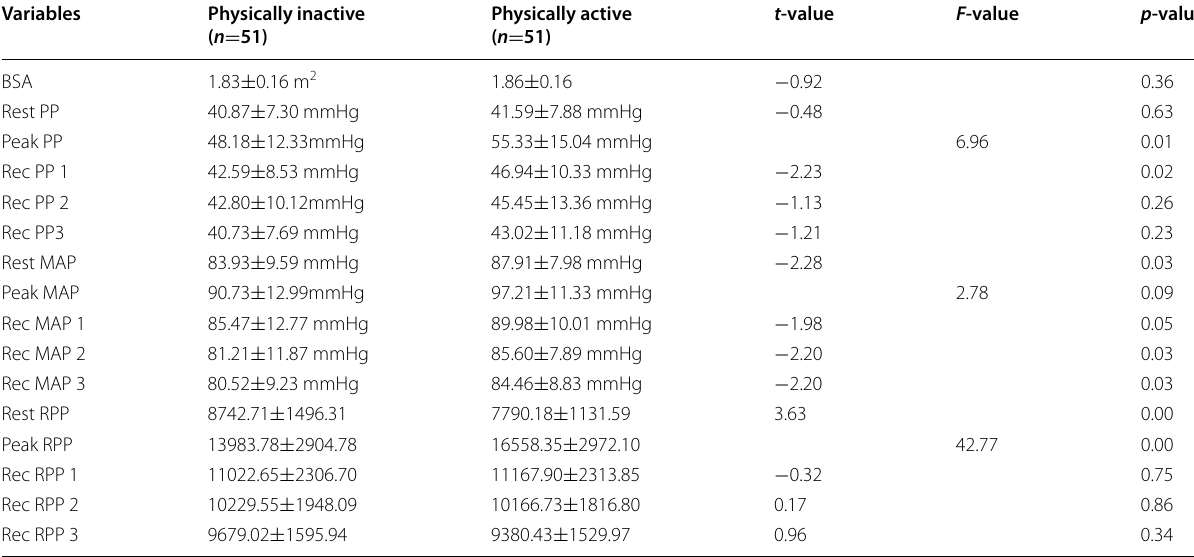
Rest PP Resting pulse pressure, peak PP Peak pulse pressure, rest MAP Resting mean arterial pressure, peak MAP Peak mean arterial pressure, rec PP1, 2, and 3 , pulse pressure 1, 3, and 5 min after exercise; rec MAP 1, 2, 3 , mean arterial pressure 1, 3, and 5 min after exercise; rec RPP 1, 2, 3 , rate pressure product 1, 3 and 5 min after exercise; NS, p > 0.05 not significant; *, p < 0.05 significant; peak PP, MAP, and RPP are based on analysis of covariance test